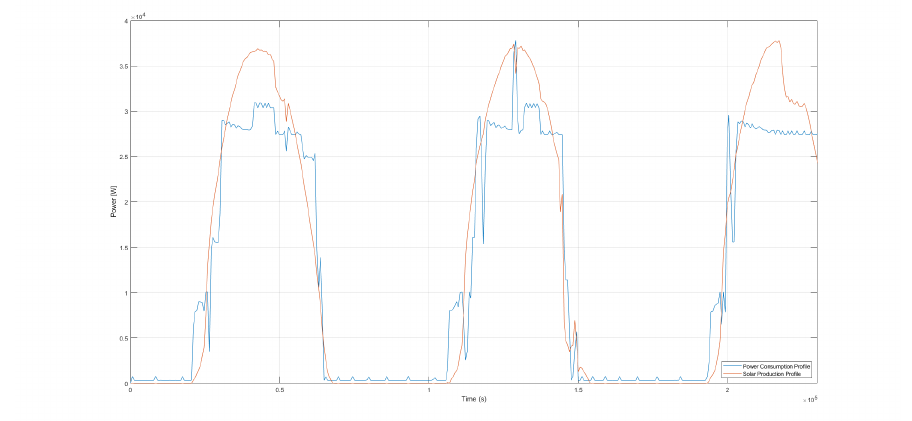
Figure 7. Profile of power produced by the solar subsystem (orange) and consumed